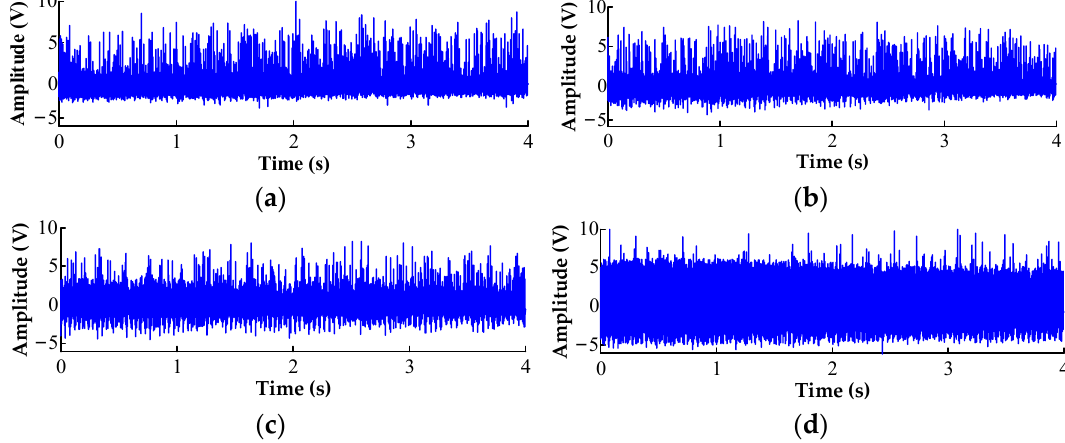
Figure 7. Vibration signals of different wear states: ( a ) Zero wear; ( b ) Mild wear; ( c ) Moderate wear; ( d ) Severe wear.